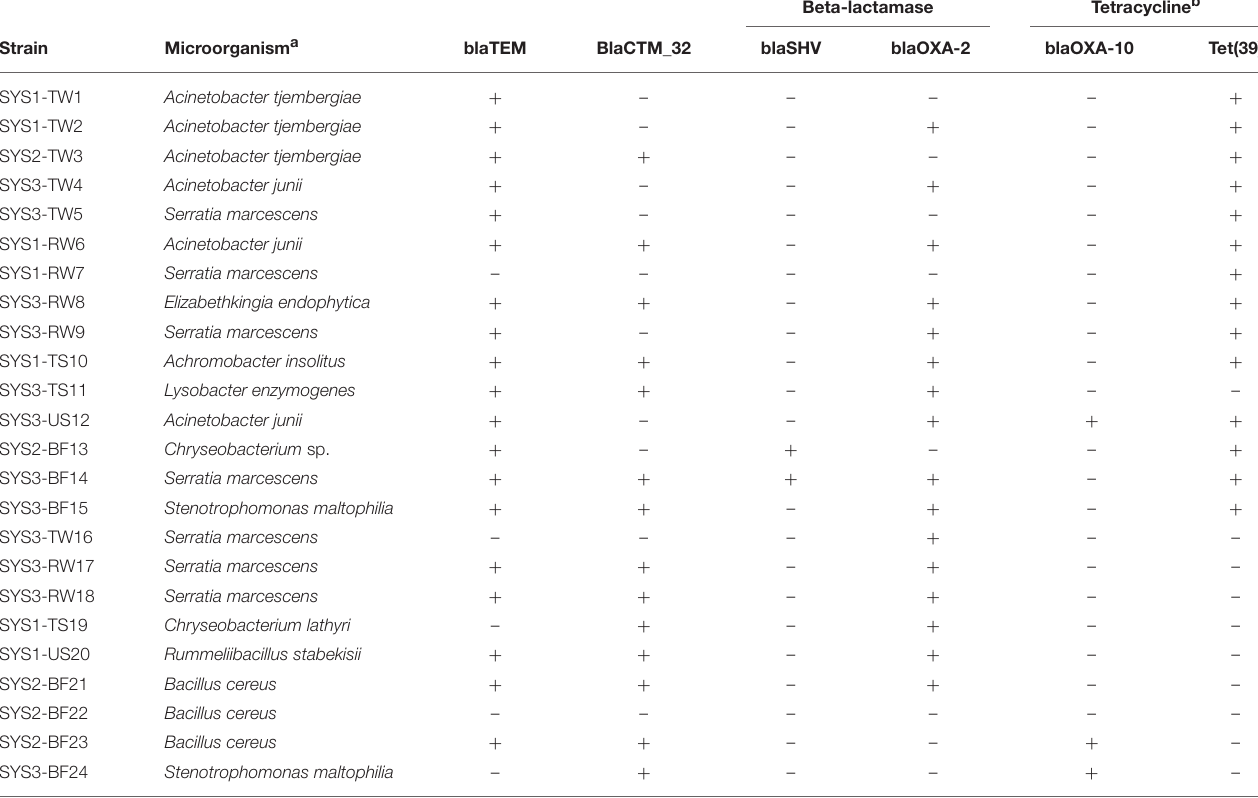
TABLE 4 | Occurrence of tetracycline and β -lactamase resistance genes in the bacterial isolates, determined by